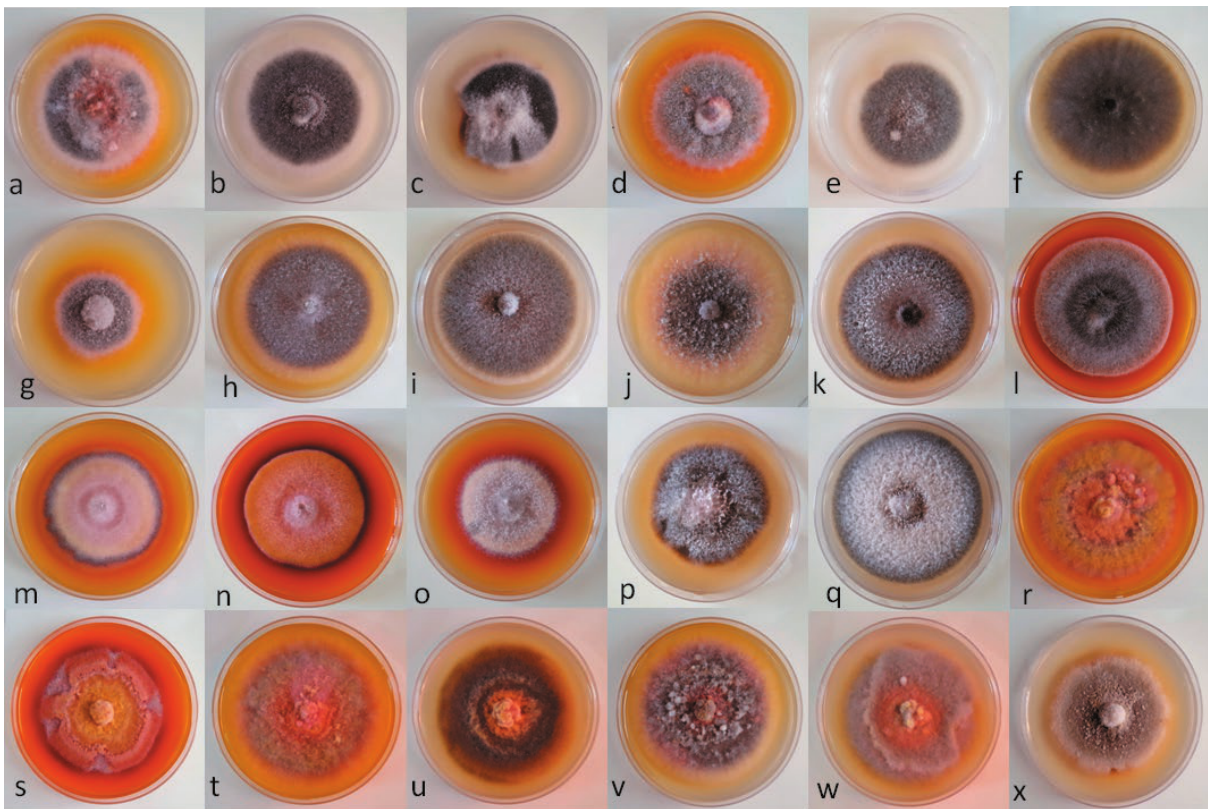
Figure 2. Colonies of 21 field isolates of Stemphylium spp. on potato dextrose agar after 7 d incubation at 25°C in the dark. Stemphylium eturmiunum , NB709 (a); NB712 (b), NB714 (c), NB731 (d), NB736 (e): S. vesicarium, NB654 (f), NB713 (g), NB715 (h), NB720 (i), NB737 (j): S. gracilariae , NB644 (k), NB646 (l), NB649 (m), NB650 (n), NB690 (o), NB696 (p), NB717 (q): S. lycopersici : NB710 (r), NB711 (s), NB719 (t), NB744 (u), NB747 (v), NB748 (w): S. lycii : NB683